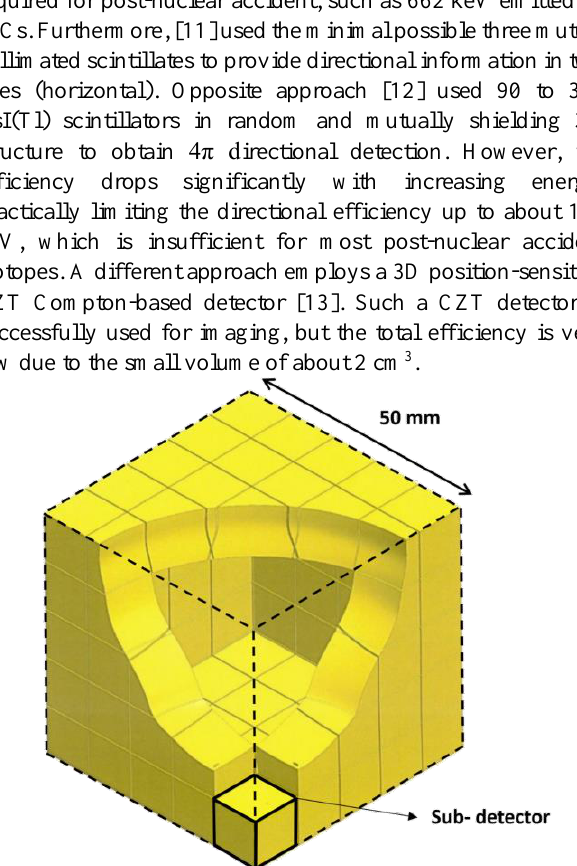
Fig. 1. The 4π directional radiation detector configuration is based on a hollow cubical structure with a segmented outer shell. Each segment made of GAGG scintillator. The whole detector size is 50 mm X 50 mm X 50